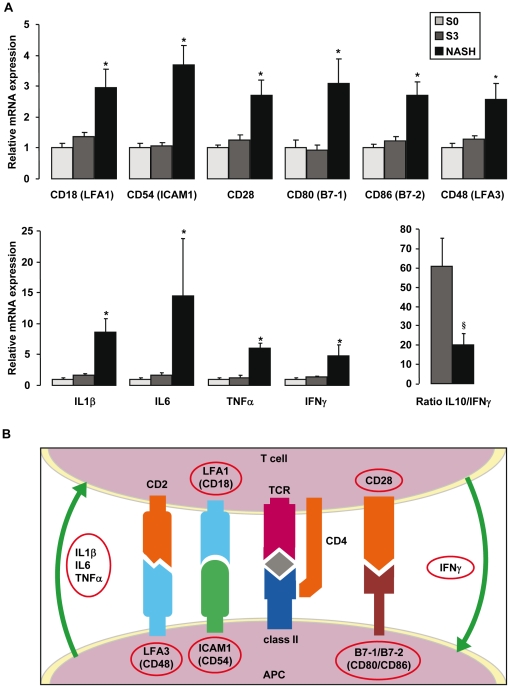
Specific upregulation of genes encoding Th1 cytokines and proteins involved in recognition between APC and T cells in liver of NASH patients.
A. The hepatic expression levels of genes were analyzed by real-time quantitative PCR in morbidly obese patients with normal liver histology (S0, n = 6), in morbidly obese patients with severe steatosis (S3, n = 6), and in morbidly obese patients with severe steatosis and NASH (NASH, n = 6). The mRNA levels of genes were normalized to the mRNA levels of RPLP0. Results are expressed relative to the expression levels in S0 patients and expressed as mean±SEM. *P<0.05, compared with S0patients; §P = 0,033. B. Scheme of recognition between APC and T cells.